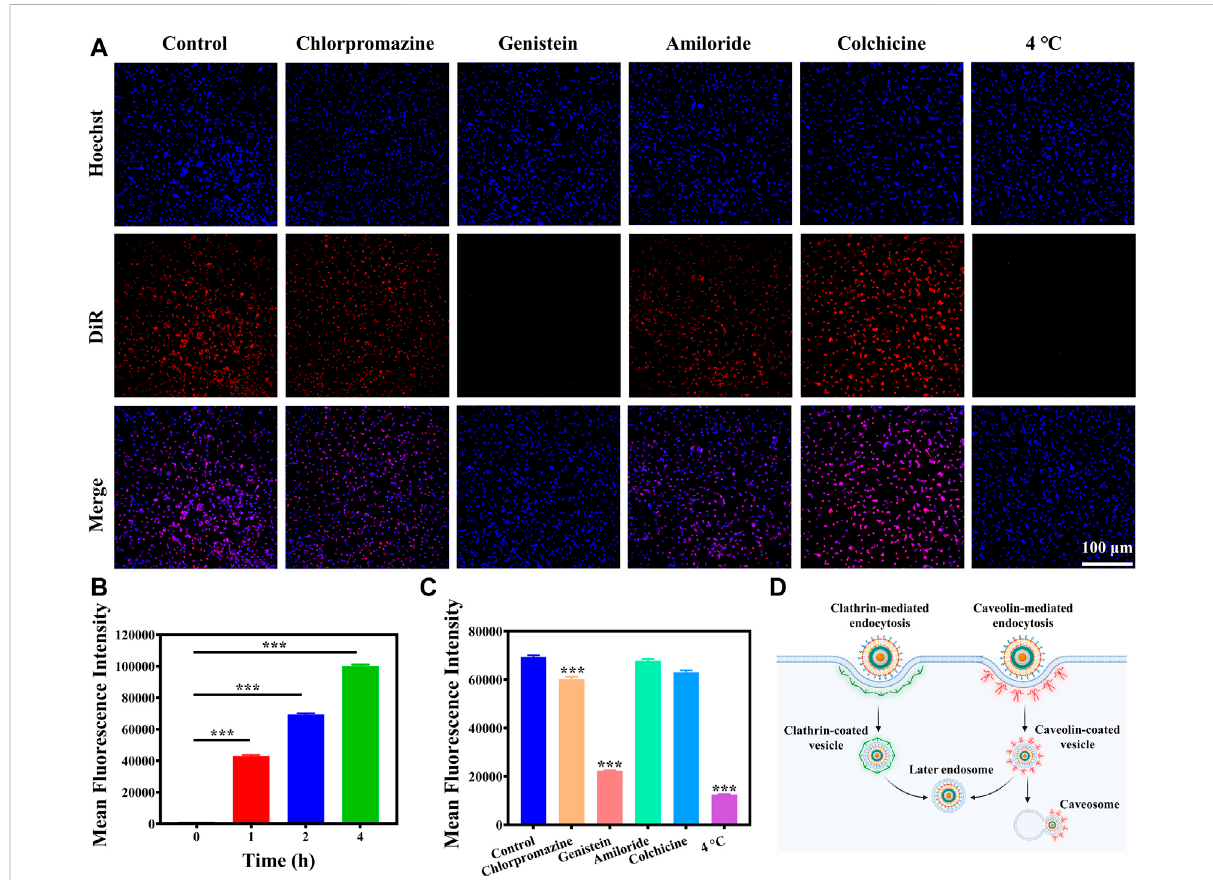
Cellular uptake and mechanism. (A) Fluorescence images ofCT26 cells pre-treated with inhibitorsand then incubatedwith DiR-labelled MCAP NPs for 2 h. (B) Flow cytometry analysis of CT26 cells incubated with DiR-labelled MCAP NPs for different times. (C) Flow cytometry analysis of CT26 cells pre-treated with inhibitors and then incubated with DiR-labelled MCAP NPs for 2 h (D) A scheme illustrated the possible cellular uptake mechanism and intracellular traf fi cking of MCAP NPs in CT26 cells (*** p < 0.001, ** p < 0.01, * p <